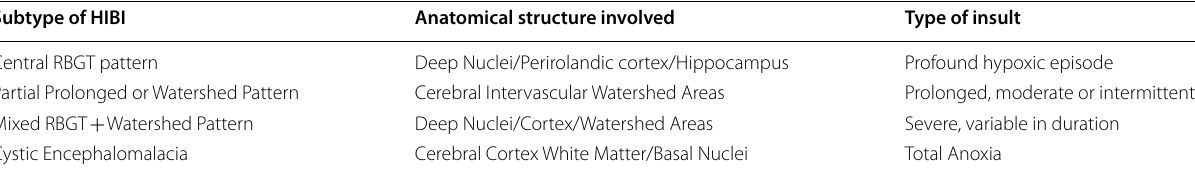
Table 1 The four main MRI patterns in patients with hypoxic–ischaemic brain injury [8]